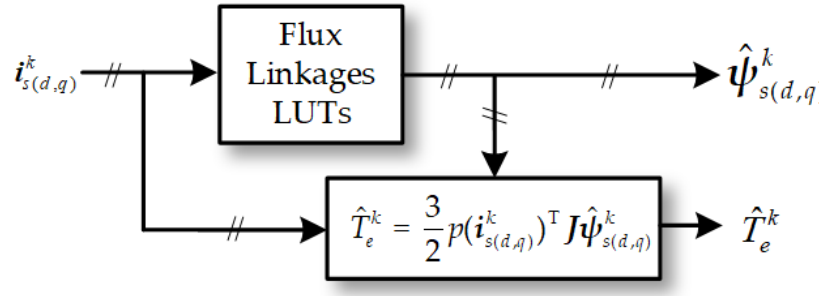
Figure 7. Torque and stator flux linkage estimation.